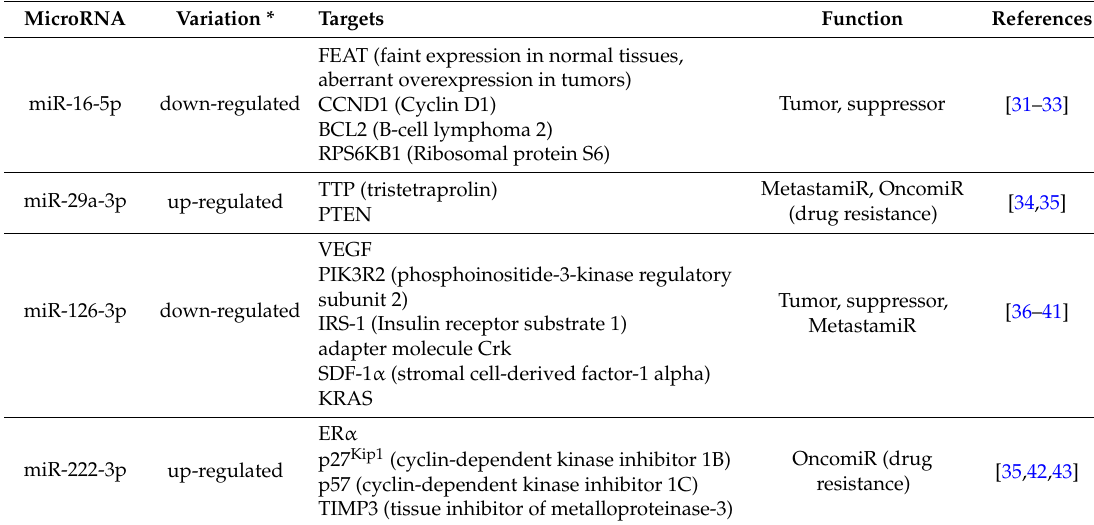
Table 3. Targets and functions in breast cancer of housekeeper